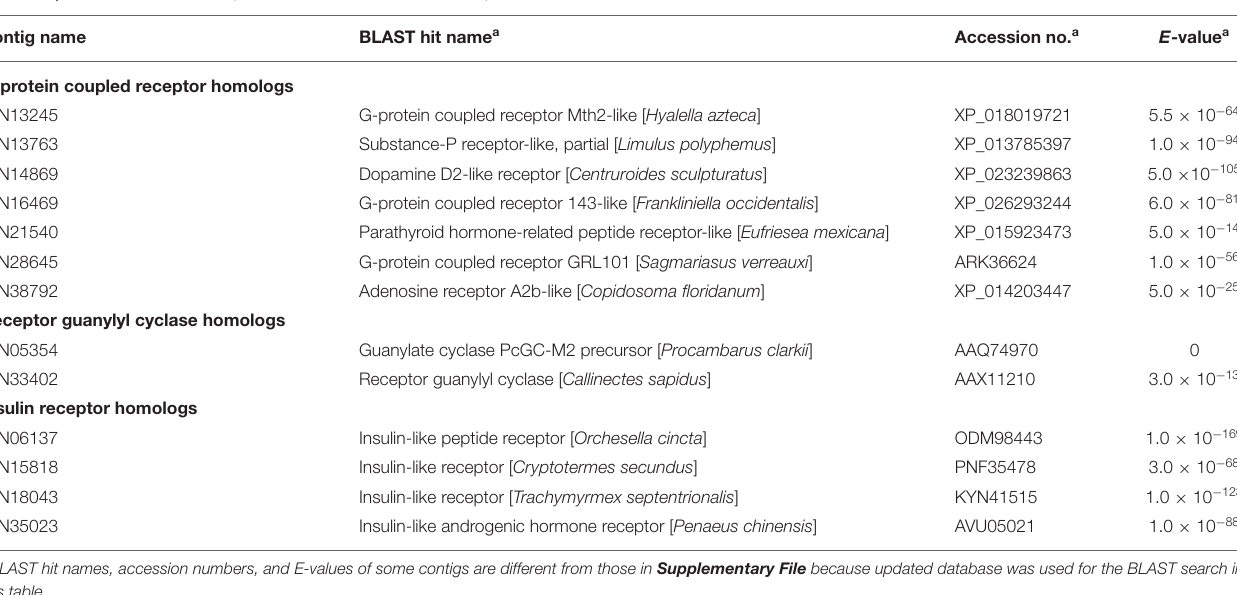
Frontiers in Endocrinology |